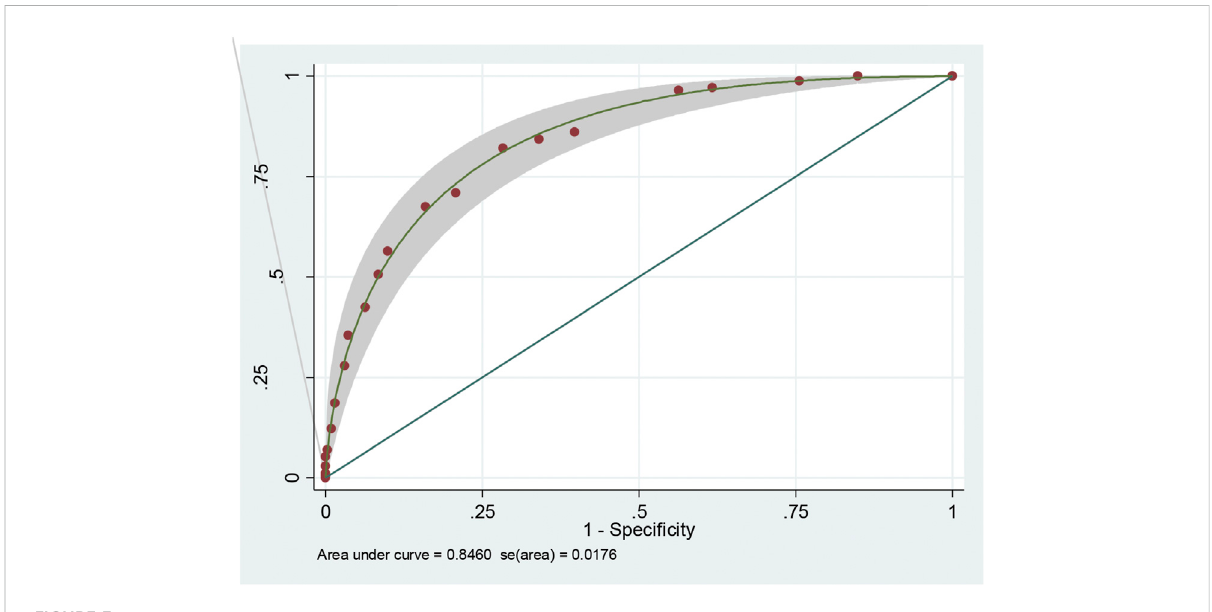
FIGURE 3 Receiver operating characteristic (ROC) curve of risk scoring